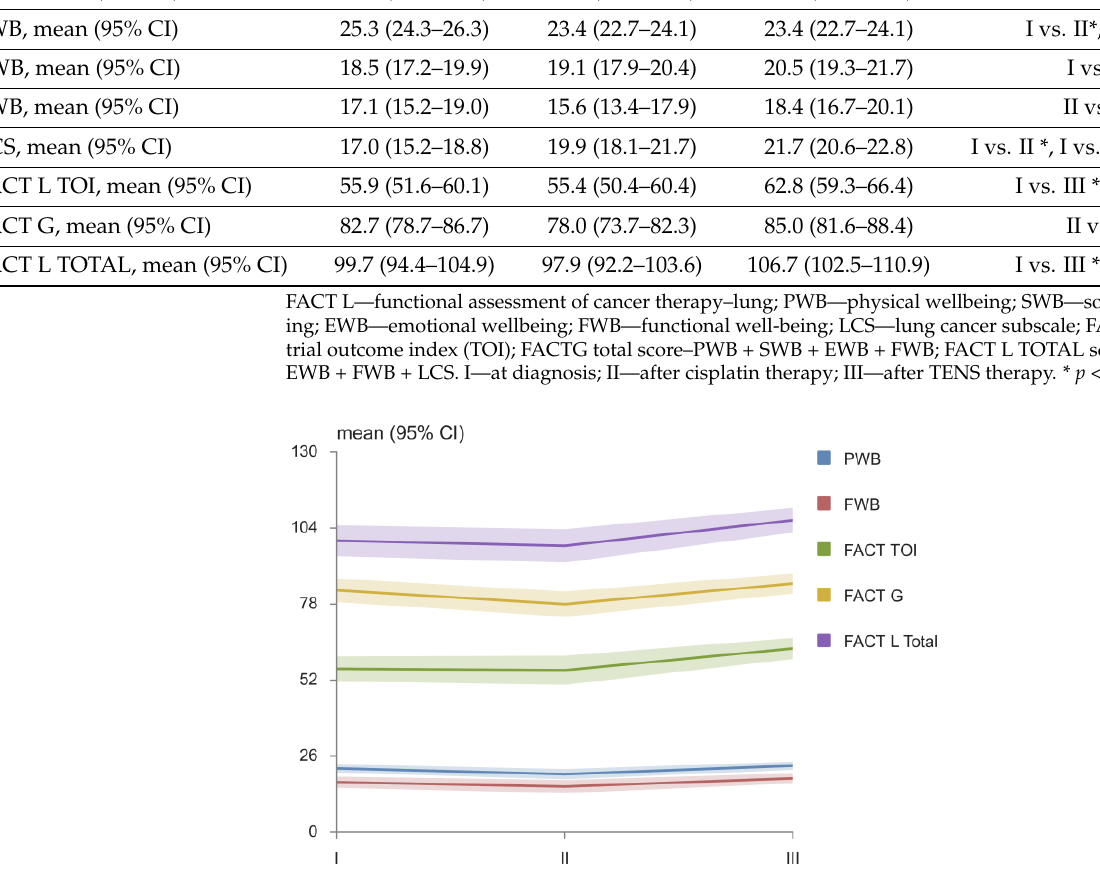
Figure 4. VAS and DN4. VAS — Visual Analogue Scale; DN4 — Douler Neuropathique in 4 ques- tions.